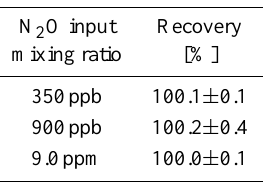
Table 2. High-precision recovery of N 2 O after preconcentration ( n =3). Error bars represent the expanded uncertainty (95% confi- dence level).